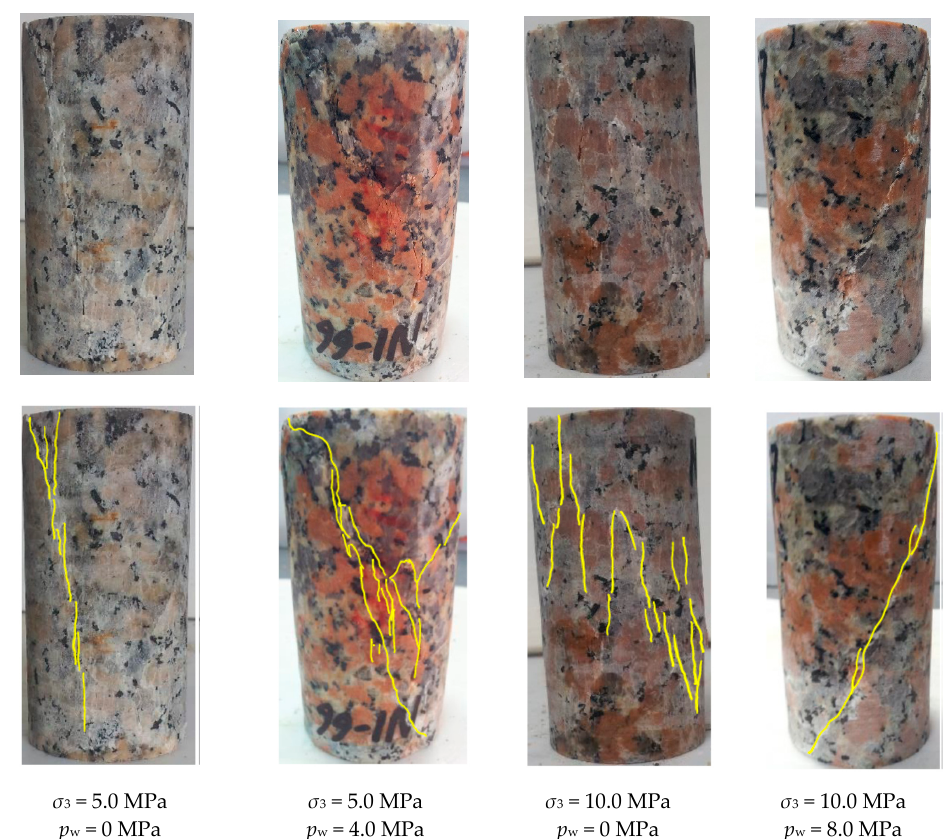
Figure 5. Fracturing patterns of NRG01 granite samples affected by water pressure under fixed confinements ( σ 3 = 5.0 MPa and 10.0 MPa). The yellow lines in the lower pictures show the fractures compared with the original pictures of the samples.